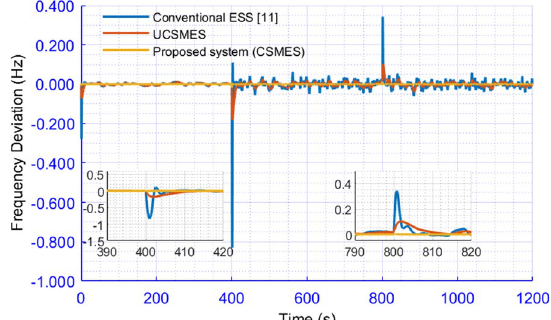
Fig. 8 Frequency deviation of the considered system for scenario A at 100% system inertia